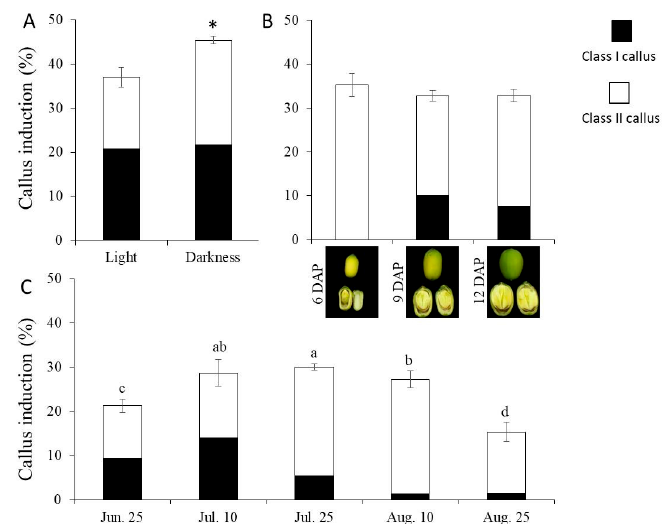
Figure 3. Evaluation of conditions affecting lotus callus induction in lotus genotype “WBG_S1.” The effects of light conditions ( A ), seed developmental stages for sampling immature cotyledon explants ( B ) and the sampling date ( C ) on lotus callus induction. Different lowercase letters and “*” indicate significant differences at p < 0.05.